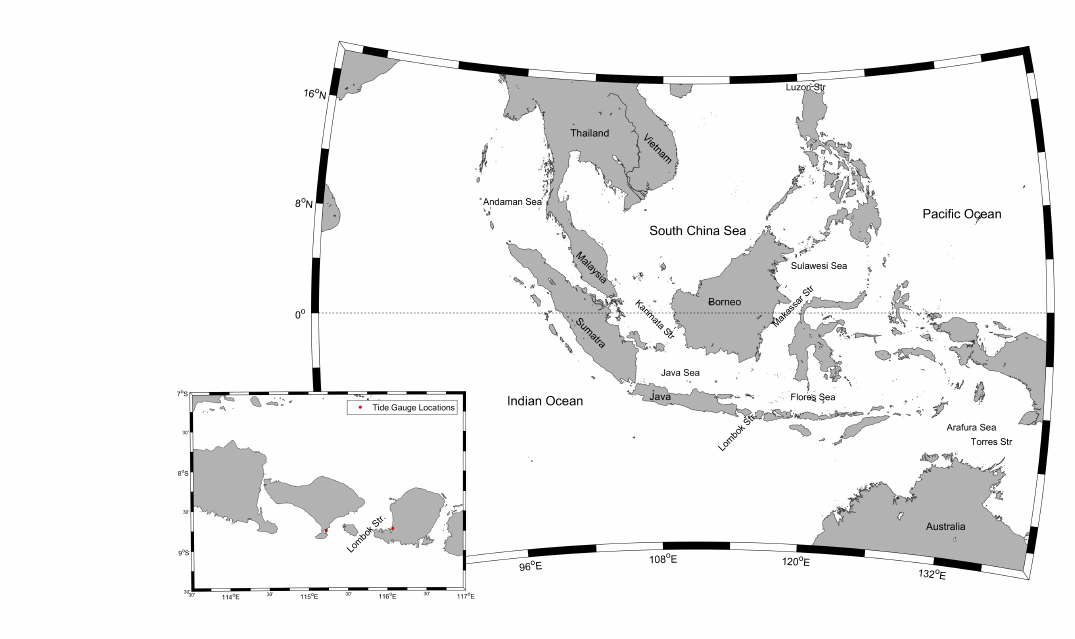
Figure 2. Map showing Indonesia with ROMS model domain inset. Tide gauge locations indicated by the red dots in the inset figure.